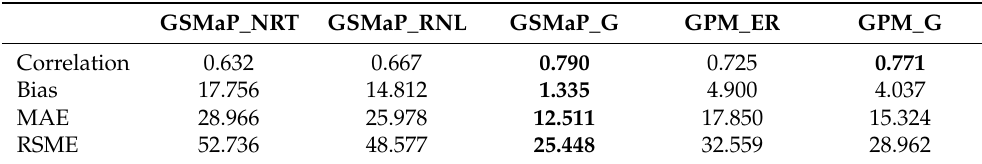
Bold number denotes statistically highest